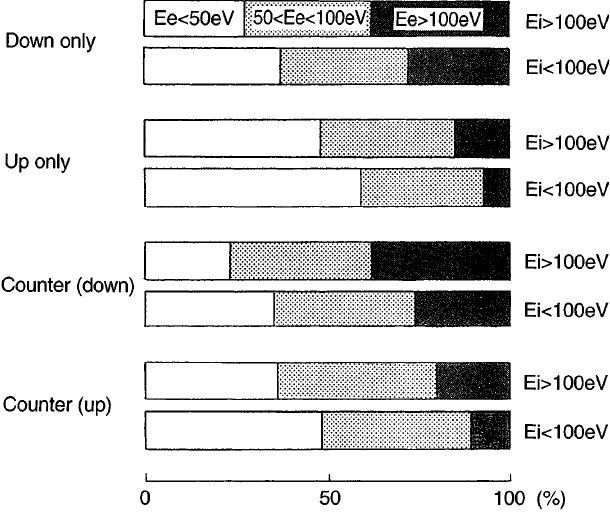
Fig. 5. Relationship of energy of ion conics ( Ei ) with that of the associated field-aligned electron beams ( Ee )